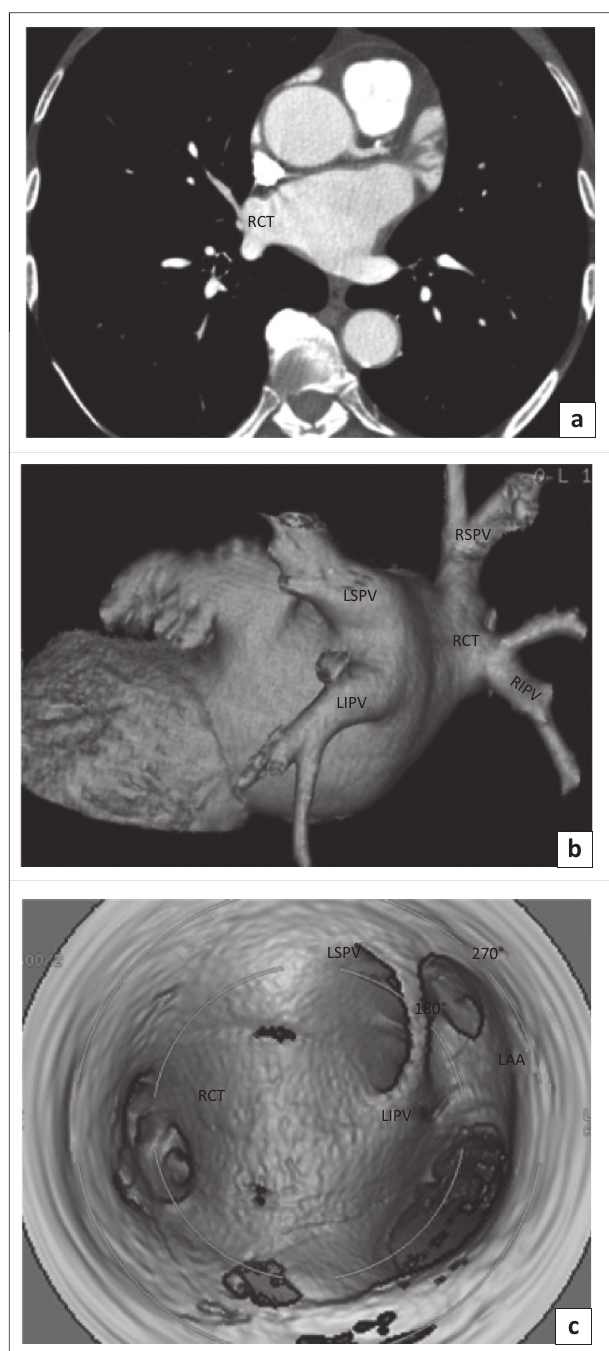
RSPV, right superior pulmonary vein; RIPV, right inferior pulmonary vein; RCT, right common trunk; LSPV, left superior pulmonary vein; LIPV, left inferior pulmonary vein; LAA, left atrial appendage. FIGURE 10: Common right trunk in another patient with atrial fibrillation: (a) Axial image. Right superior pulmonary vein (RSPV); (b) Three-dimensional model. Right superior pulmonary vein (RSPV), right inferior pulmonary vein (RIPV), right common trunk (RCT), left superior pulmonary vein (LSPV) and left inferior pulmonary vein (LIPV); (c) Endocardial view. Right common trunk (RCT), left superior pulmonary vein (LSPV), left inferior pulmonary vein (LIPV) and left atrial appendage